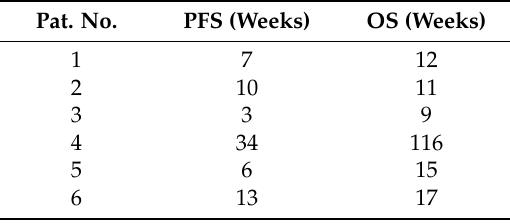
Table 2. Progression-free and overall